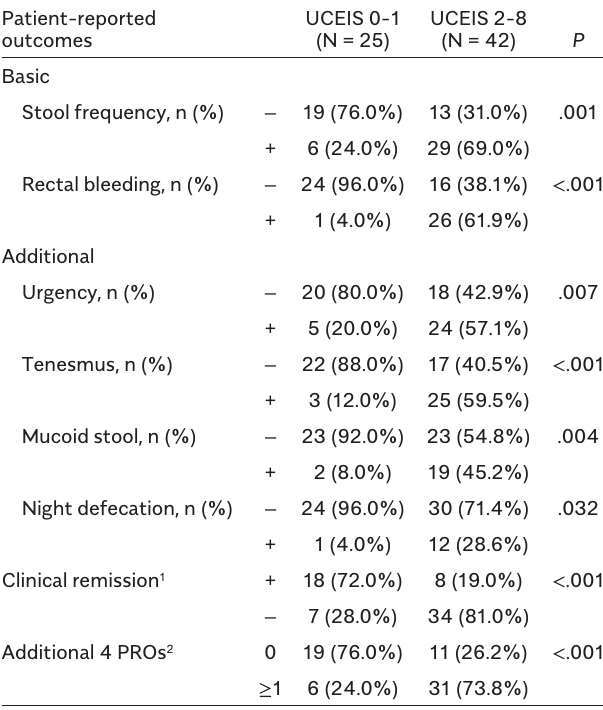
Supplementary Table 2. Prediction of UCEIS 0 by Basic and Additional Patient-Reported Symptoms and Laboratory